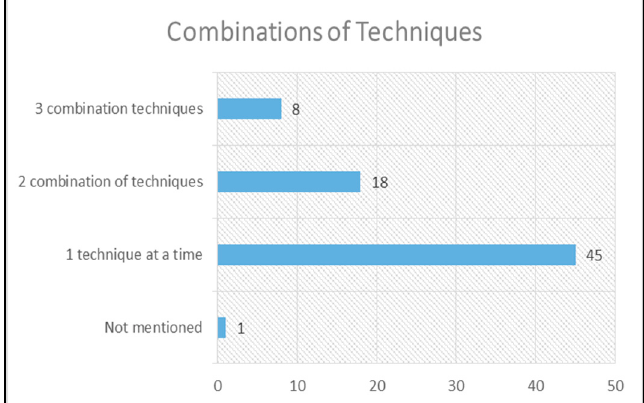
Figure 7. Research papers and usability technique combinations.